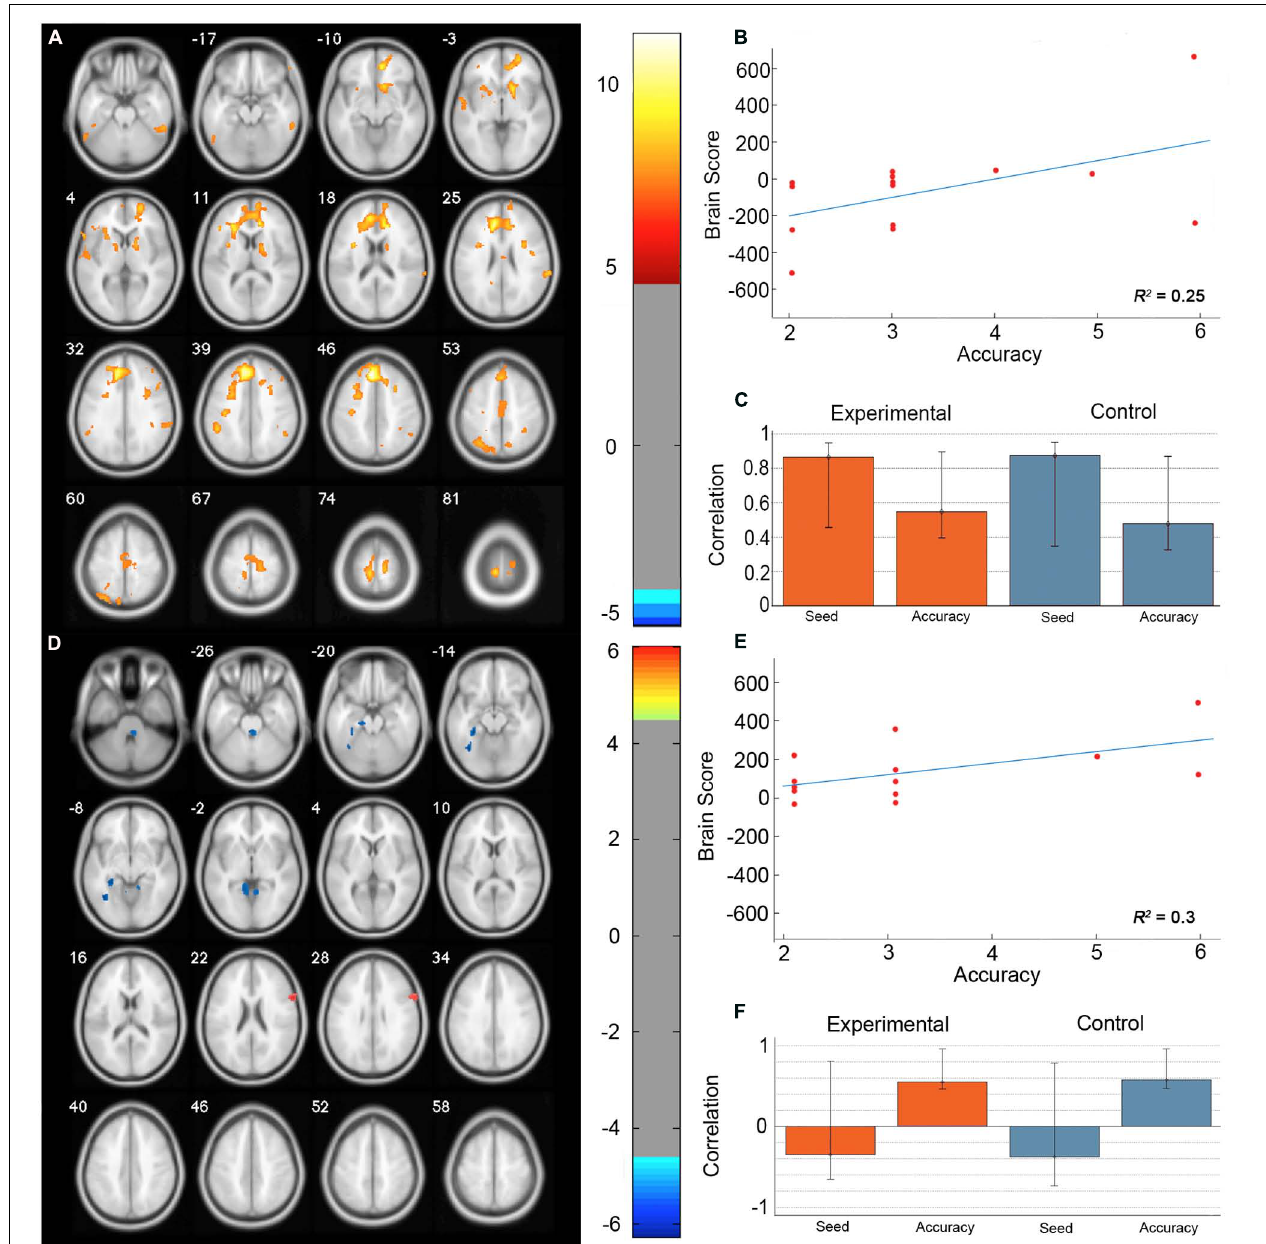
FIGURE 3 | Results from the seed behavior PLS. (A) Singular value image from LV1 ( p < 0.001). Red and yellow regions represent brain areas where increased BOLD activity was associated with high accuracy on the path integration task and correlated with BOLD signal changes in the peak PFC voxel from the task PLS (MNI coordinates x = − 8, y = 32, z = 42).This PFC networks suggested increased expression of spatial attention and working memory systems during path integration correlates with more accurate estimation of motion displacement. (B) Correlation between individual brain scores from LV1 and accuracy in estimating path distance. (C) Correlation between LV1 and data matrix columns representing the seed voxel activity and behavioral accuracy across experimental and control trials. Error bars represent bootstrapped 95% confidence intervals. (D) Singular value image